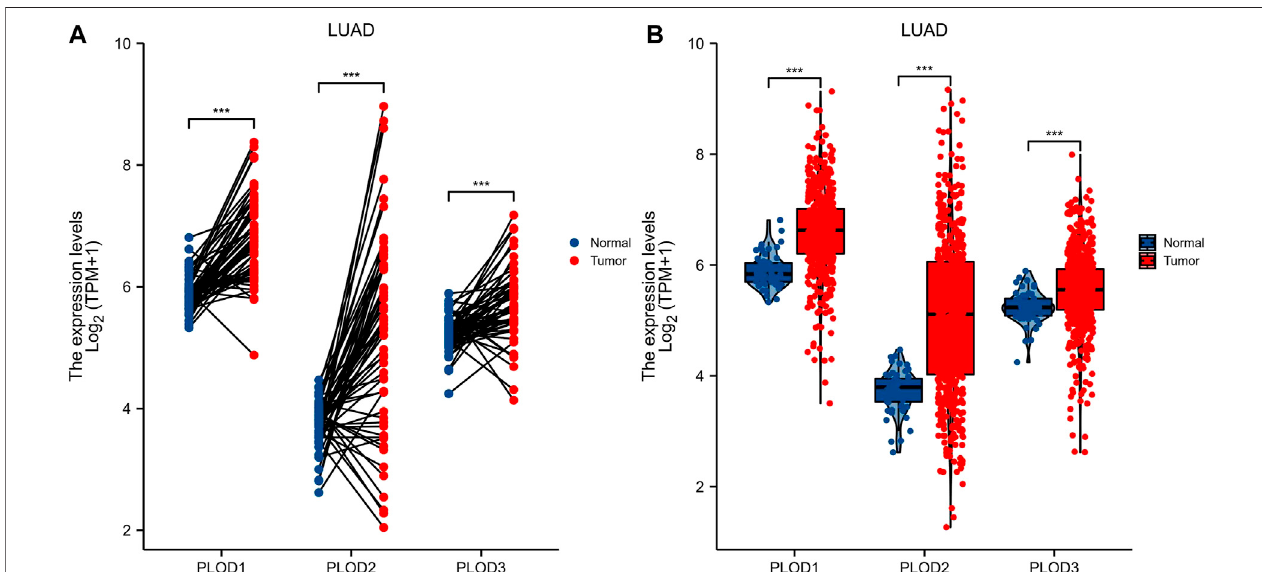
FIGURE 2 | PLOD mRNA expression. Through TCGA database data screening and analysis, the expression of PLOD family genes in normal tissues and LUAD tissue samples was determined. (A) mRNA expression levels of PLOD1 , PLOD2 , and PLOD3 in LUAD tissues and matched adjacent normal samples. (B) mRNA expression levels of PLOD family genes in 535 lung adenocarcinoma samples and 59 normal samples. The results showed that, compared with normal lung tissue, the expression of PLOD1 , PLOD2 , and PLOD3 mRNA in LUAD increased signi fi